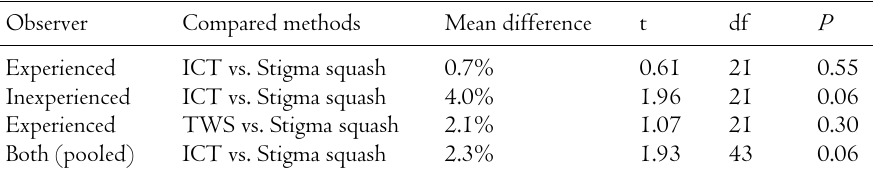
T ABLE 1: Comparison of the pollen counts determined by the stigmagraph processing methods and the pollen counts on the stigma squash slides for an experienced and an inexperienced observer. A positive mean difference indicates that the first method listed estimated a higher number of grains than the second method.